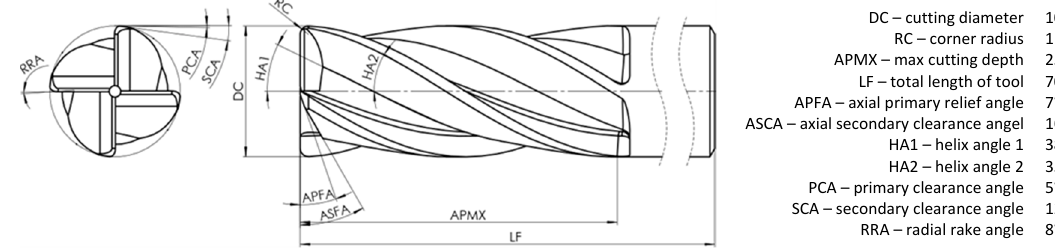
Table 2. The features of nanocrystal coating in comparison with other types.